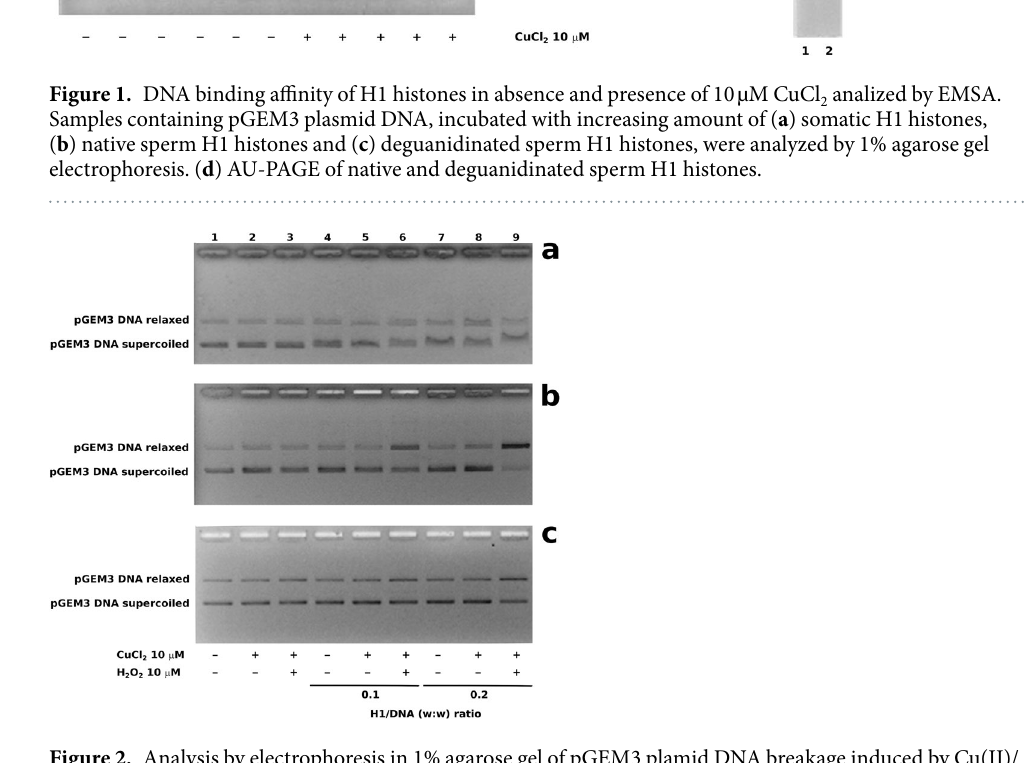
Figure 2. Analysis by electrophoresis in 1% agarose gel of pGEM3 plamid DNA breakage induced by Cu(II)/ H 2 O 2 in presence of ( a ) somatic H1 histones, ( b ) native sperm H1 histones and ( c ) deguanidinated sperm H1